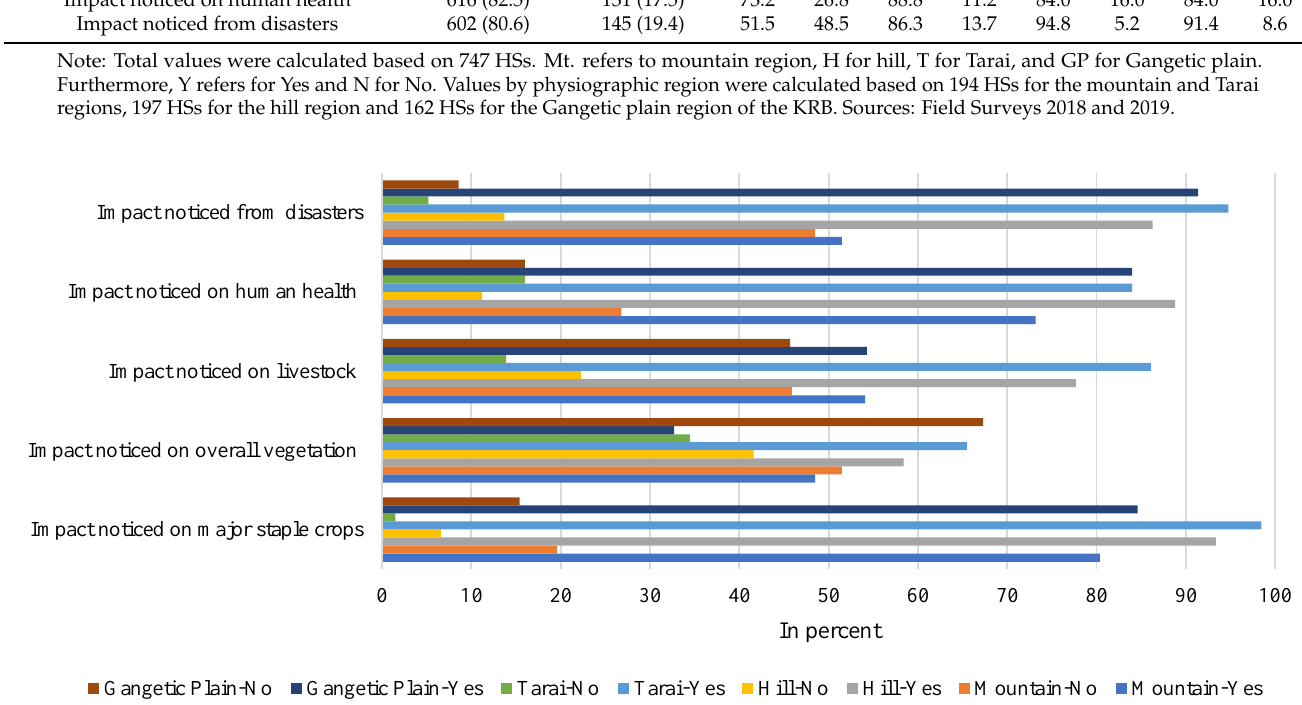
Table 4. Attributes for heads of household for the farmers surveyed in the trans-boundary KRB.